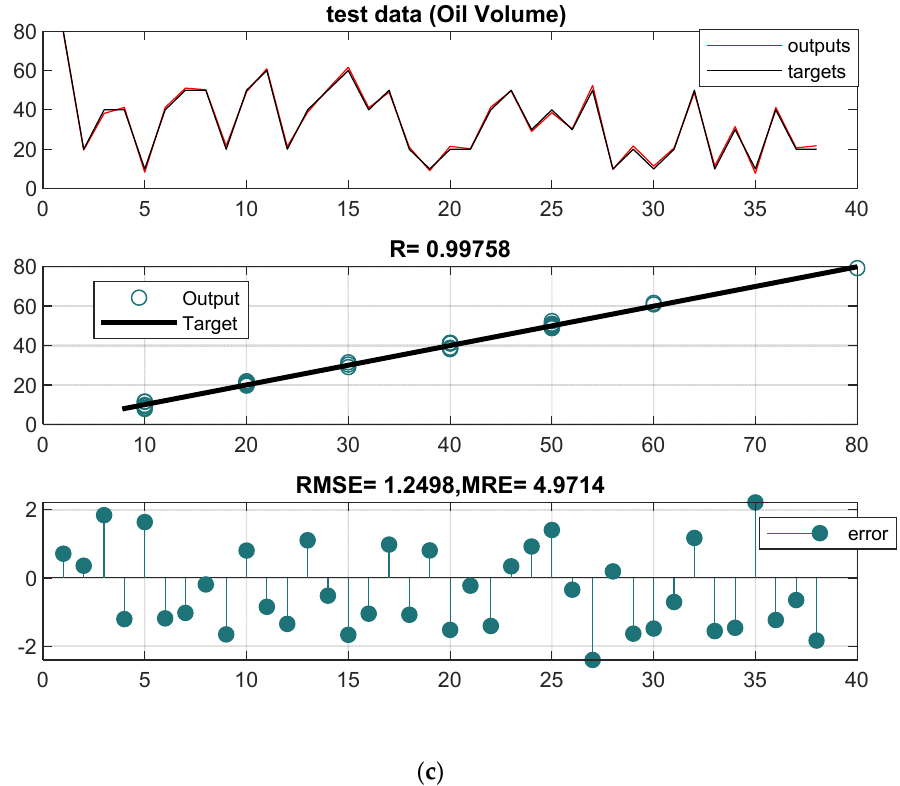
Figure 6. Fit and error graph for ( a ) training, ( b ) validation, and ( c ) testing data related to oil volume-percentage predictor neural network.